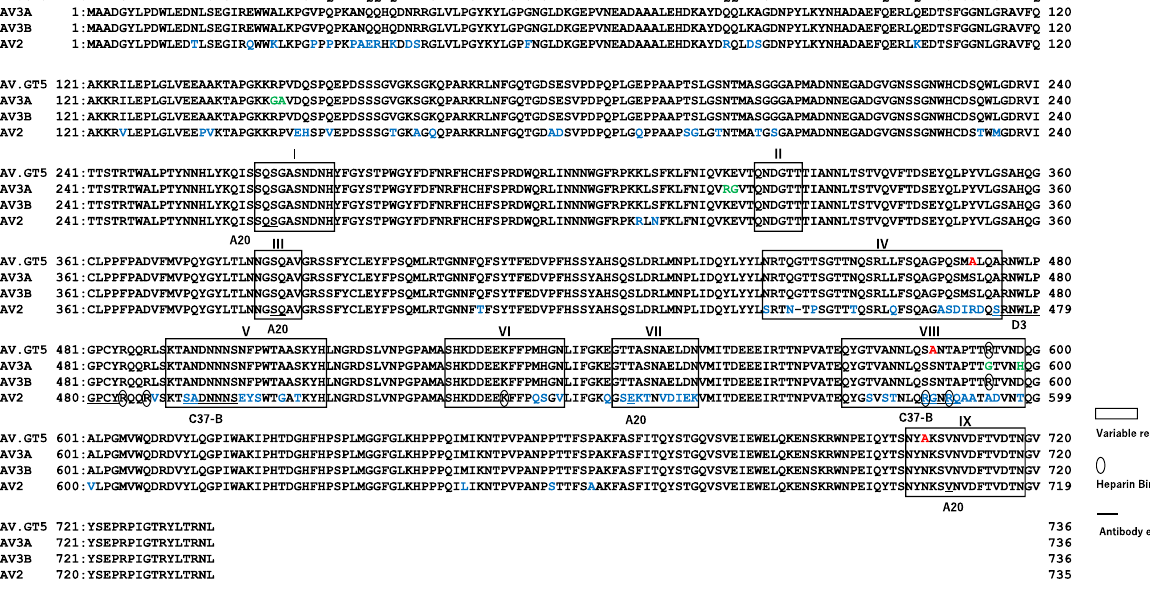
Figure 1. Comparison of VP1 amino acids of AAV.GT5 with AAV2, AAV3A, and AAV3B. Surface variable regions (VR-1 to VR-IX) are boxed. Amino acid residues that bind to heparan sulfate are indicated with ellipse. Epitopes of antibodies against AAV2 (A20, D3, and C37-B) are underlined. Substitution of three amino acids, S472A, S587A, and N706A, on the surface loop of AAV3 are shown in red. Amino acids in AAV2 and AAV3A that are different from those in AAV3B are shown in blue and green,